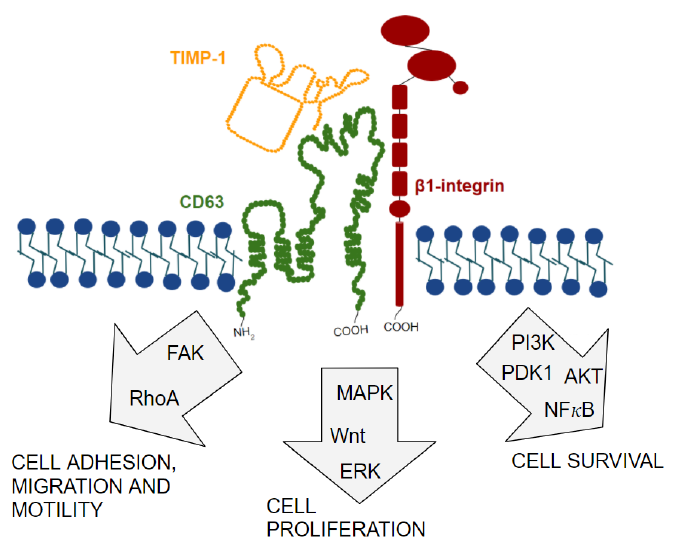
Figure 4. Different intracellular signaling pathways activated by the TIMP-1/CD63/ β 1-integrin supramolecular complex. Activation of these pathways modulates cell behavior, including cell adhesion, migration, proliferation, and survival.